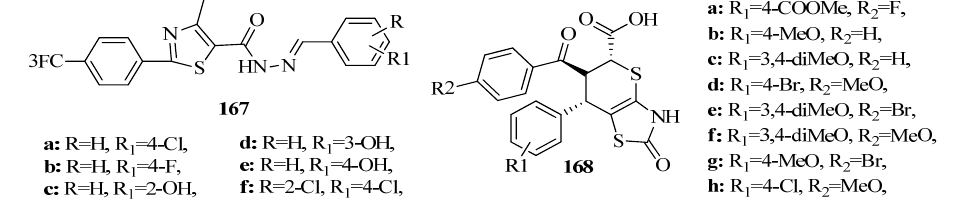
Figure 65. Structures of new acyl-hydrazones bearing thiazole scaffold ( 167 ) and new thiopyrano[2,3- d ]thiazoles ( 168 ).